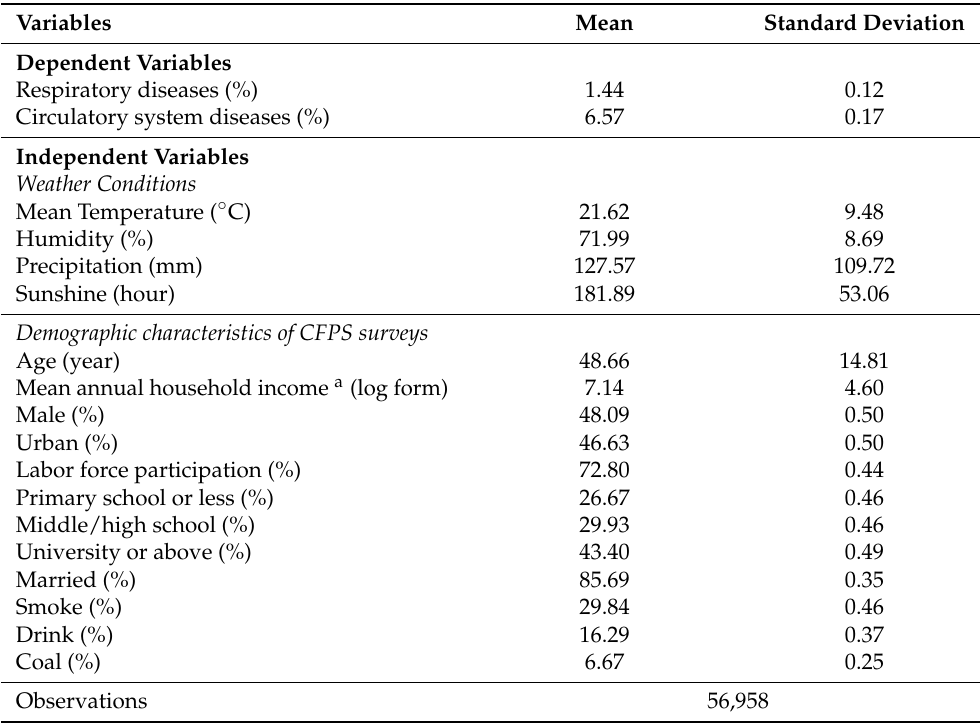
Table 2. Descriptive statistics: CFPS2012, 2014,